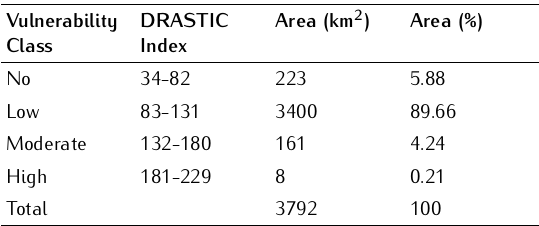
Table 9. The final modified DRASTIC index ( DI + DL ( i )+ MD ( i )) for the study area.